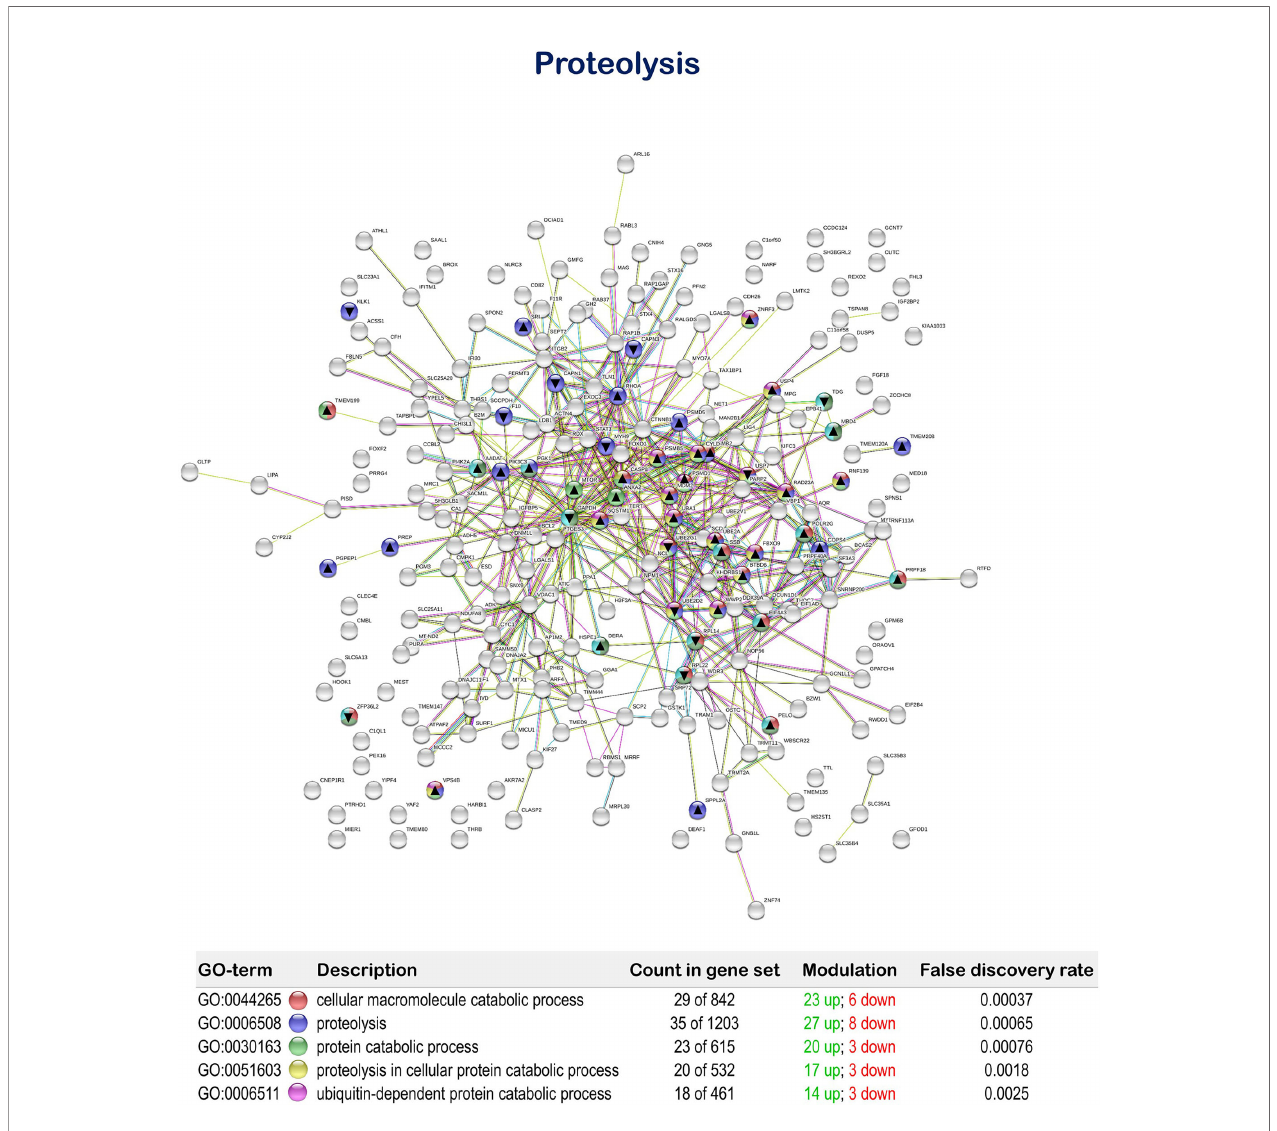
FIGURE 7 | Proteolysis related Protein-Protein Interactions Network (PPI) network of the differentially expressed genes (DEGs) in the mid-anterior intestine of juvenile gilthead seabream ( Sparus aurata ) fed the mixture of MPLE obtained from sage ( S. of fi cinalis ) and lemon verbena ( L. citriodora ) (see also Supplementary Table 5 ). Nodes colors indicate the biological processes for each DEG represented. Gene Ontology (GO) de fi nitions, count of DEGs within each biological processes and respective false discovery rate are described in the graphical fi gure legend. ▲ nodes represent up-regulated genes and ▼ nodes represent down-regulated genes. Graphic keys and network stats are indicated in the graphical fi gure legend. Network Stats: number of nodes: 243; number of edges: 550; average node degree: 4.53; avg. local clustering coef fi cient: 0.416; expected number of edges: 423; PPI enrichment p-value: 1.98e-09. The MPLE included in the basal diet was obtained from sage ( Salvia of fi cinalis ) and lemon verbena ( Lippia citriodora